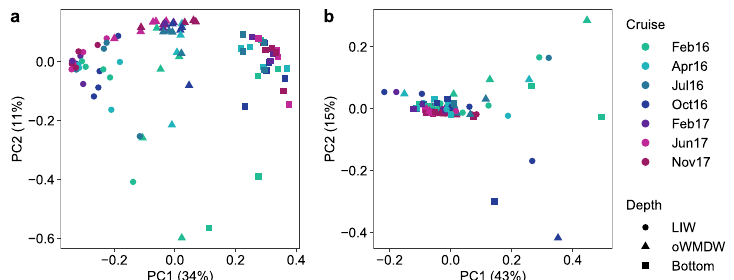
Figure 3. Principal coordinates analysis (PCoA) of aphotic Mediterranean Sea prokaryotic communities. Principal coordinates analysis (PCoA) of prokaryotic communities based on ( a ) Bray Curtis and ( b ) weighted UniFrac distance matrices. The percentage of variance explained by each principal coordinate is indicated in the corresponding axis. Water masses are shape coded and cruises are colour coded. LIW: Levantine intermediate water; oWMDW: old western Mediterranean deep